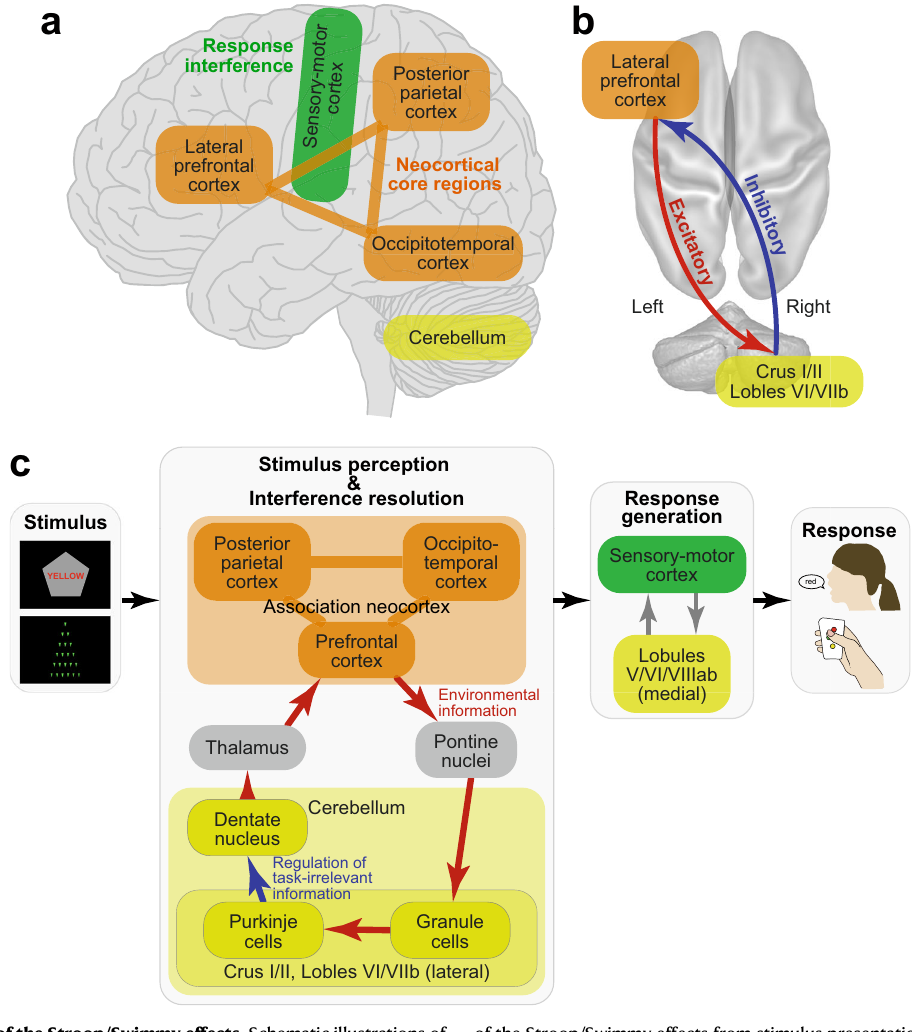
of the Stroop/Swimmy effects from stimulus presentation to response execution. Anatomicalstructureandfunctionalitiesofthefront-cerebellarlooparespeculated based on previous anatomical and neurophysiological